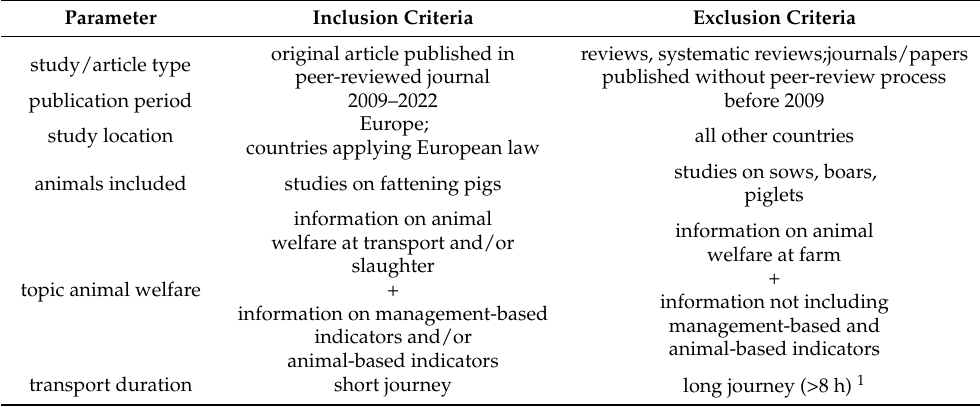
Table 1. Inclusion and exclusion criteria for the systematic literature review on animal welfare of pigs during transport and